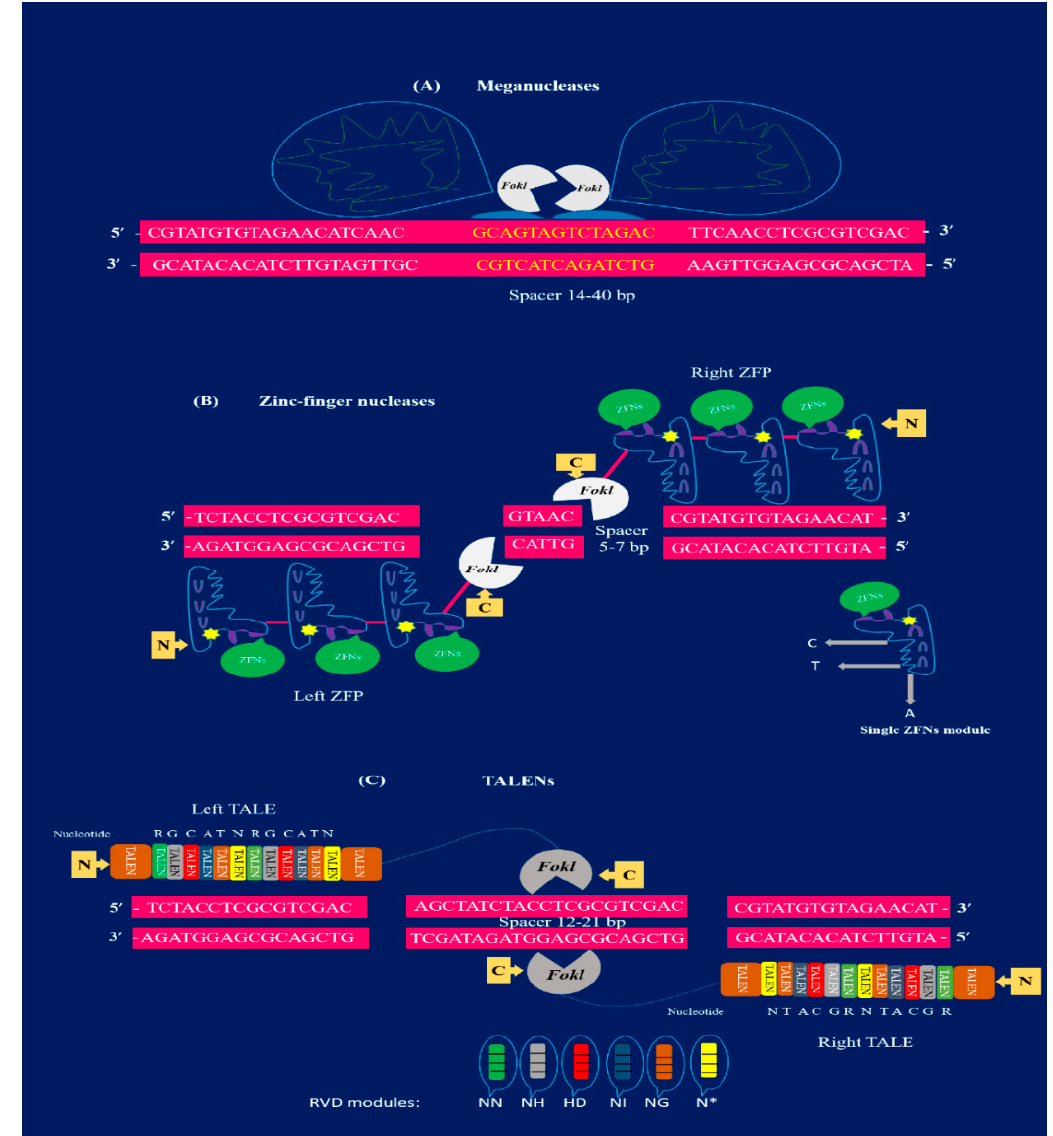
Figure 1. Structural illustration of first-generation genome editing tools: ( A ) meganucleases (MNs) have multifunctional domains with the ability to bind double-stranded target DNA and generate DSBs. The meganuclease is demonstrated to bind a target spacer sequence of 14–40 bp (yellow). The FokI nuclease cuts the target sequence (color). ( B ) Representation of ZFN bound to the target sequence of 18–36 bp long. Each monomer of ZFN (blue) is made by ZFP. There are two basic domains: the DNA binding domain at N-terminus and the catalytic domain with FokI nuclease (white) present at the C-terminus. The connection among these domains is indicated with a pink line. The ZFN modules are merged with Fok1 (white) and dimerized to cut the target sequence at a spacer 5–7 bp (pink) to produce DSBs. ( C ) Two TALEN dimers bound to the target sequence (pink) site. Each module of TALENs are composed of TALE that contain 33–35 amino acid repeats. The pair of TALENs are separated by a spacer region of 12–21 bp (pink). There are specific RVD modules (green NN, grey NH, red HD, dark blue NI, orange NG, and yellow N) that can recognize only one single nucleotide. TALE modules are dimerized to fuse with FokI (at C-terminus) to produce DSBs in the spacer region.